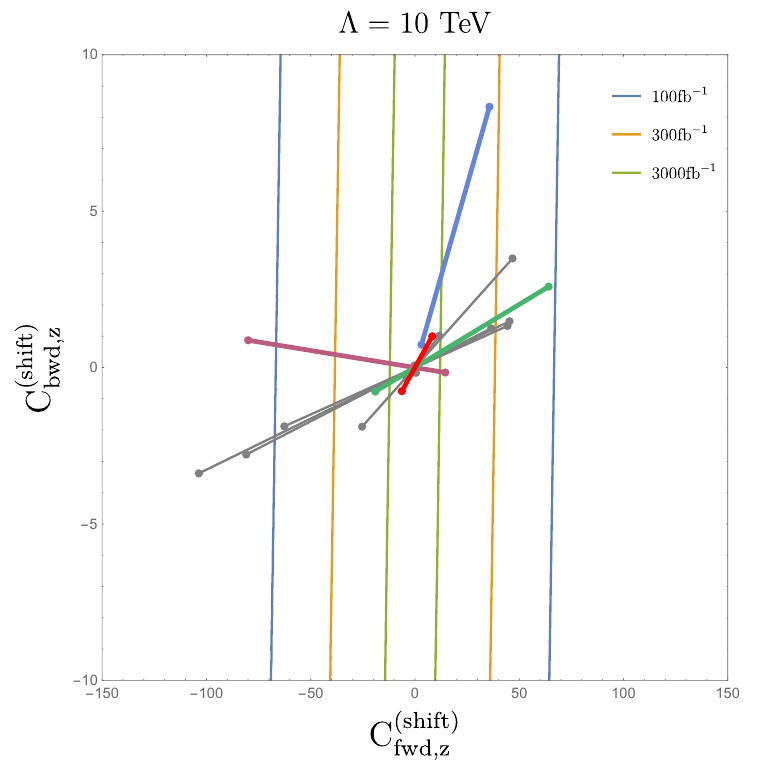
Figure 3. 1 (cid:27) constraints from our proposed LHC measurements in the same space as (cid:12)gure 2, zoomed in on the SM-like point. 1 (cid:27) constraints from LEP and other low-energy data as reported in [9] are overlaid for each operator contributing to the LHC process, considered one-at-a-time. Because of the linearity of the leading-order calculation, and the one-at-a-time operator approach, these are straight lines of allowed points. Highlighted in red, green, purple, and blue are the operators Q Hd , Q Hl 1 , Q HWB , and Q He ,